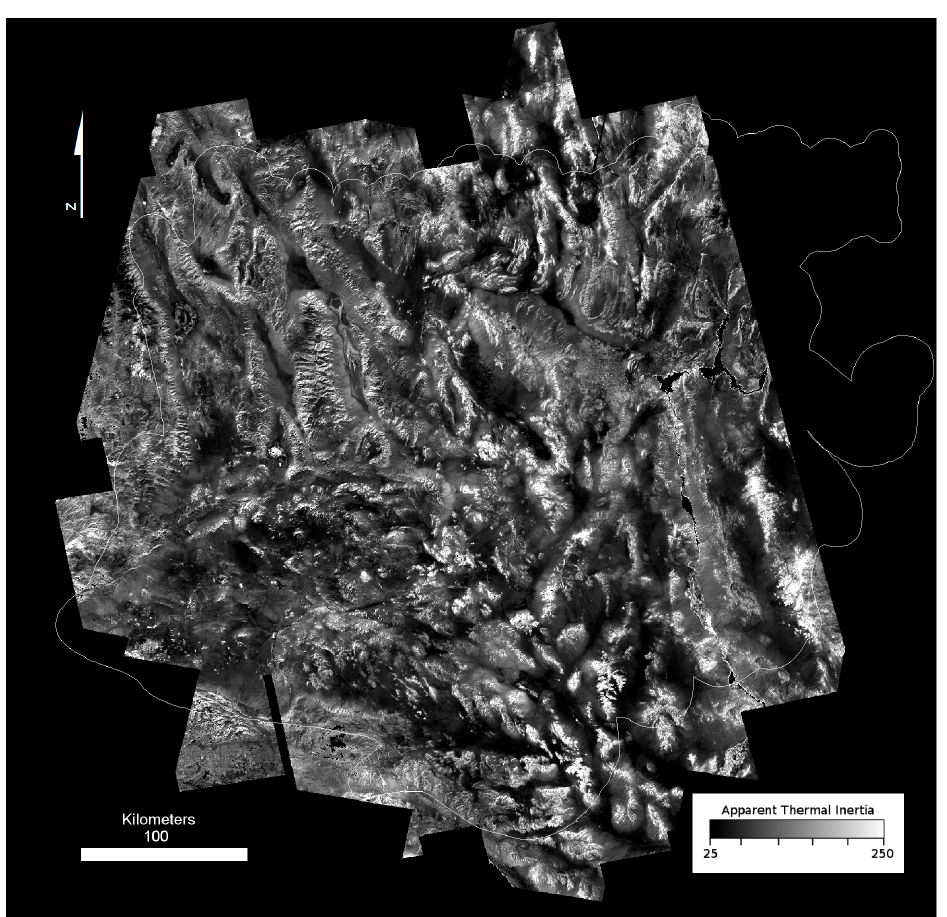
Figure 7. Apparent Thermal Inertia (ATI) of the Mojave. High values represent rockier, more indurated or consistently wet surfaces and lower values represent finer grain size sediments.